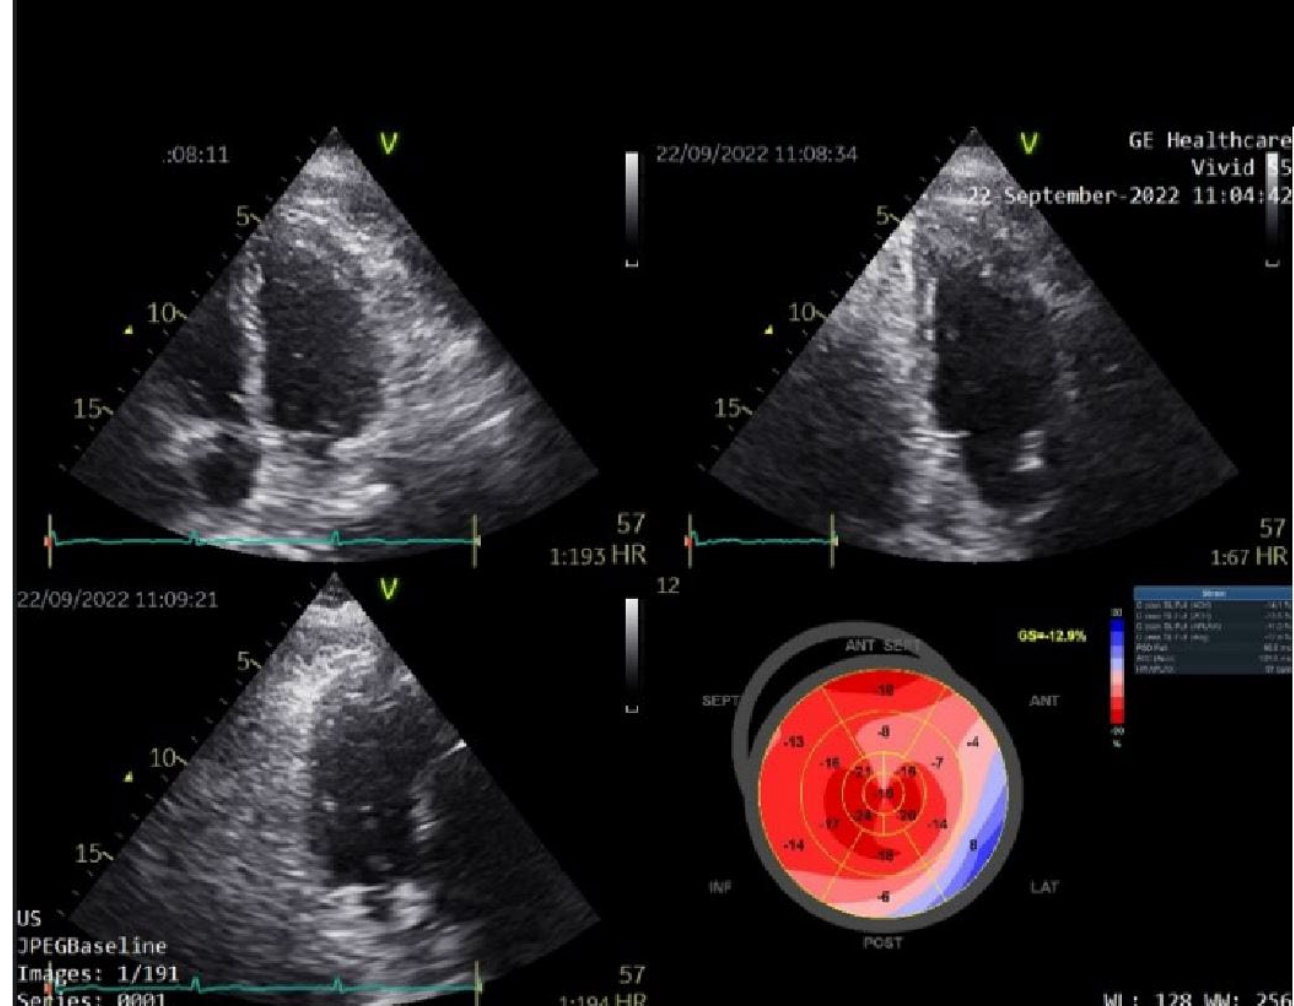
Figure 2. Two-dimensional echocardiography and Bull’s-eye map representation of global longitu- dinal strain of the left ventricle.